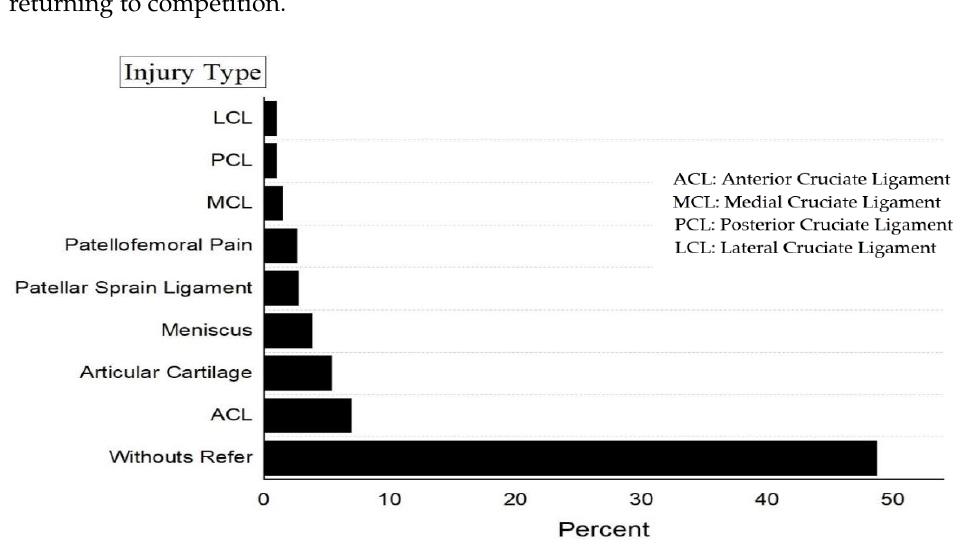
Figure 2. The knee injuries distributions among participants.